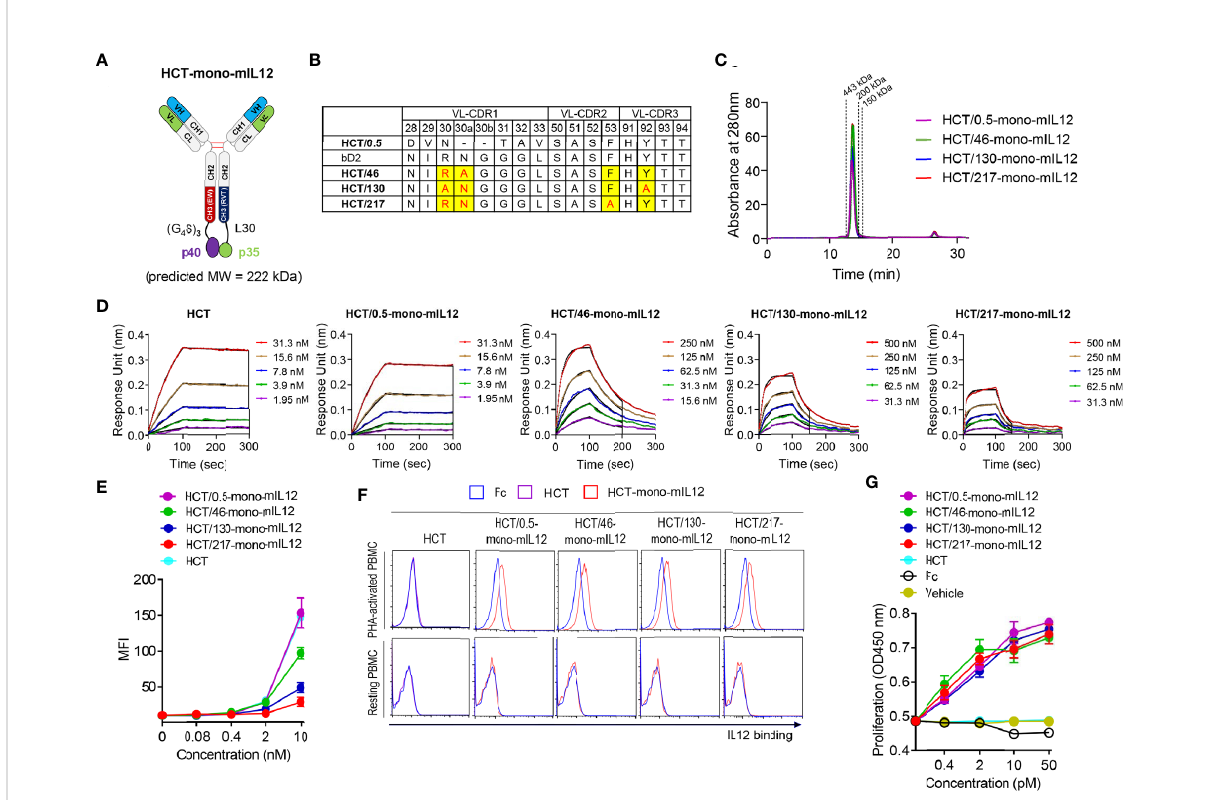
FIGURE 1 Generation and characterization of HCT-mono-mIL12 variants with different anti-HER2 binding kinetics. (A) Schematic diagram of HCT-mono- mIL12, where the two subunits of mIL12, p40 and p35, were separately fused to the C-terminus of heterodimeric Fc-based HC via (G 4 S) 3 and a 30-residue linker (L30), respectively. (B) The sequence alignment of VL-CDRs of HCT variants highlighting the mutated residues in VL-CDRs of bD2. (C) SEC elution pro fi les of the puri fi ed HCT-mono-mIL12 (30 m g loading amount each). The dotted lines indicate the elution positions of molecular mass standard markers: 443 kDa (apoferritin), 200 kDa ( b -amylase), and 150 kDa (alcohol dehydrogenase). (D) Representative binding isotherms of the immobilized HCT or HCT-mono-mIL12 to soluble HER2 antigen, measured by bio ‐ layer interferometry. The concentrations of HER2 analyzed are indicated in different colors as de fi ned in the in-graph legends. The binding kinetics ( k on and k off ) and af fi nities ( K D ), shown in Table 1, were obtained by global fi tting of the association and dissociation phases (indicated by the black vertical line) with R 2 ≥ 0.99. (E) Dose- dependent binding of HCT (control) or HCT-mono-mIL12 to CT26-HER2/neu cells, measured by fl ow cytometry and represented by the mean fl uorescence intensity (MFI). (F) Binding activities of Fc (40 nM), HCT (40 nM), or HCT-mono-mIL12 variants (40 nM) for resting and PHA- activated PBMCs, analyzed by fl ow cytometry. (G) Proliferation of PHA-activated PBMCs after 72 h culture with the indicated concentrations of Fc (control), HCT (control), or HCT-mono-mIL12 variants. Data in (C, D, F) are representative of three independent experiments. Data in (E, G) represent the mean ± SD